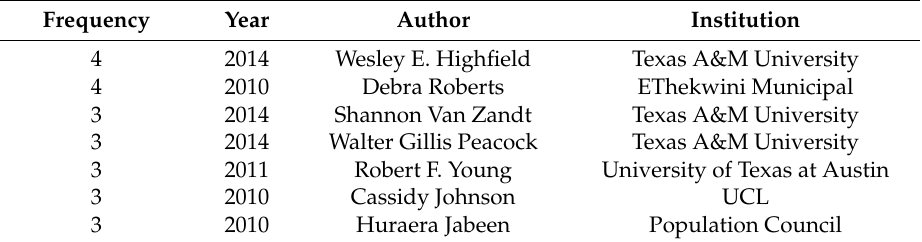
Table 1. The publication frequencies, institutions of the top 13 most productive